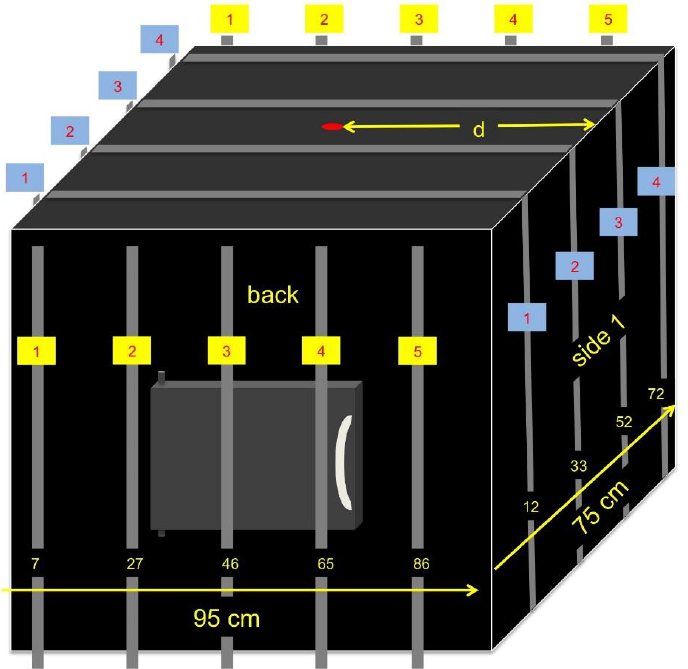
Figure 22. Sketch of the twenty-two positions on top and around the AmBe source box where the measurements with the SciFi detector were performed. The projection of the source position on the top plane is shown and the exact value of d is not known.